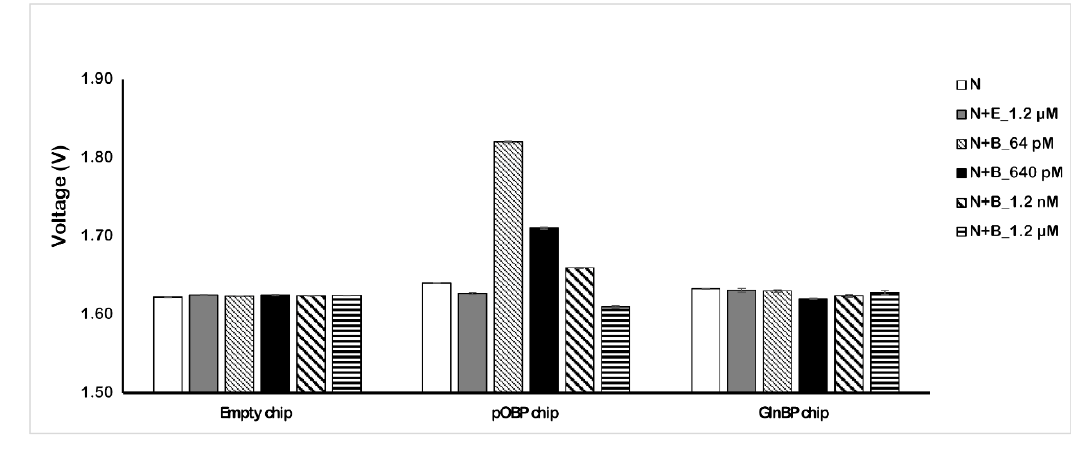
Figure 6. Variation of the voltage in the absence (nitrogen and ethanol) and in the presence of different concentrations of benzene (from 64 pM to 1.2 µM). The measurements were acquired in gas at room temperature by using the 75 µm sensor chip configuration. Table 3. Variation of the 75 µm sensor chip voltage in three different conditions.